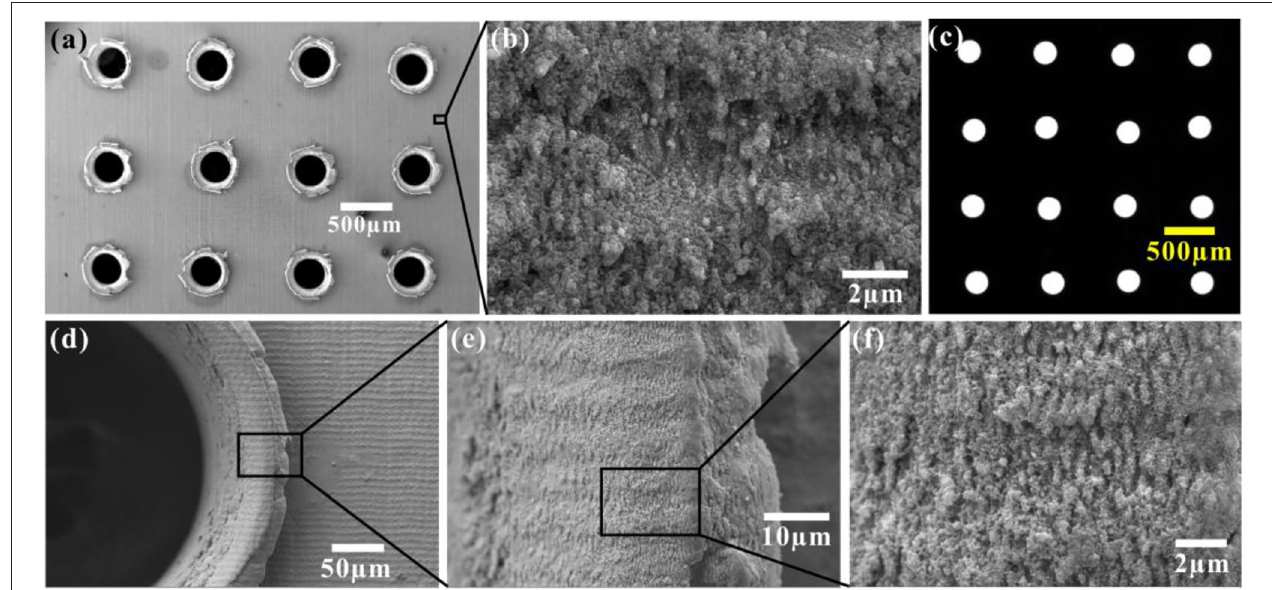
FIGURE 3 | Femtosecond laser-induced porous underwater superoleophobic metal sheet. (a) SEM image of the nanostructured porous sheet. (b) High-magnification SEM image of the domain between open microholes. (c) Optical microscopy photo of the porous sheet. The sample was lighted by white light from the backside. (d–f) SEM images of the edge ridge of a